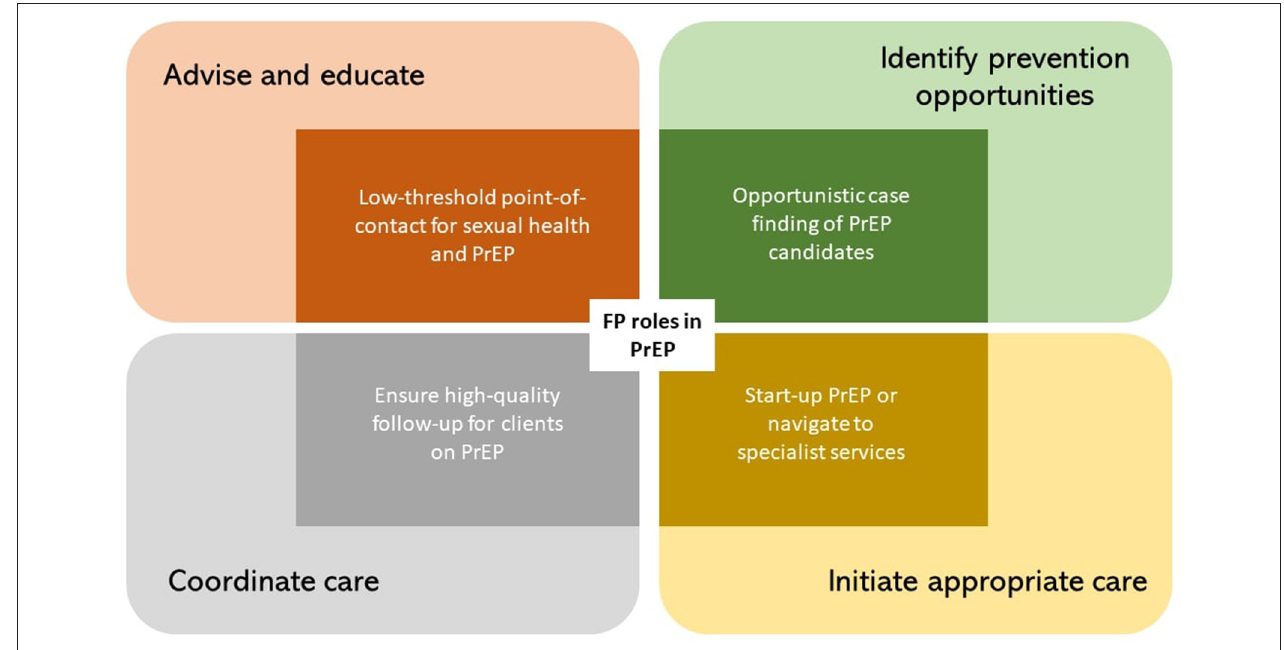
FIGURE 1 | Four self-perceived roles of the FP in PrEP (inner rectangles), framed within their respective more generic FP roles (outer rectangles).